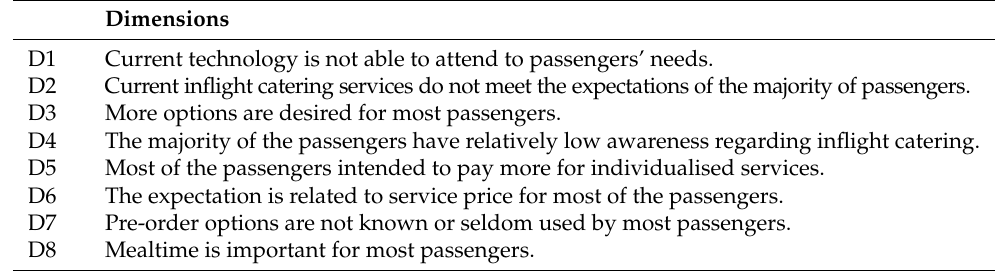
Table 1. Individualisation dimensions for the research model.